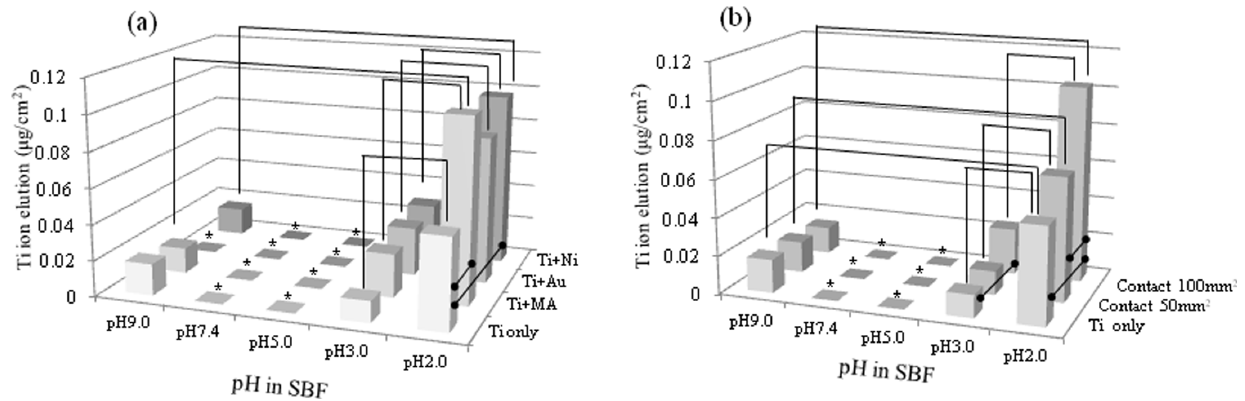
Figure 6. Ti ion elution from a specimen of CP Ti immersed for 72 in an SBF solution and that from a specimen of CP Ti immersed while in contact with a specimen of a dissimilar metal or metallic alloy. (a) shows the effect of the metal or metallic alloy type and (b) the effect of the contact area.